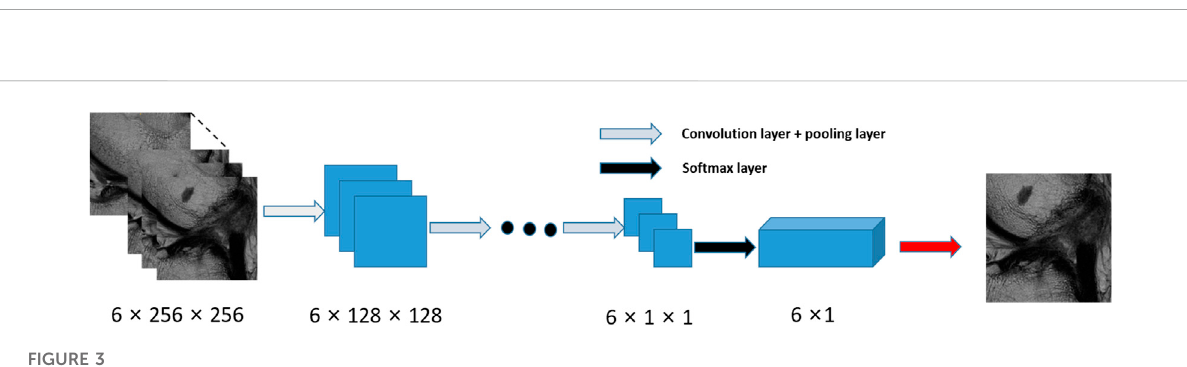
FIGURE 2 The convolutional neural network (CNN) pipeline for the deep learning-based fully automated ACL rupture localization system. The proposed methods including 2D and 3D CNNs consisted of segmentation and landmark detection network connected in a cascaded fashion to create a fully automated image processing pipeline. ACL, anterior cruciate ligament; BN, batch normalization; Conv, convolution; Norm, normalization; LReLU, Leaky-ReLU; ReLU, recti fi ed-linear activation; 2D, two-dimensional; 3D, three-dimensional.